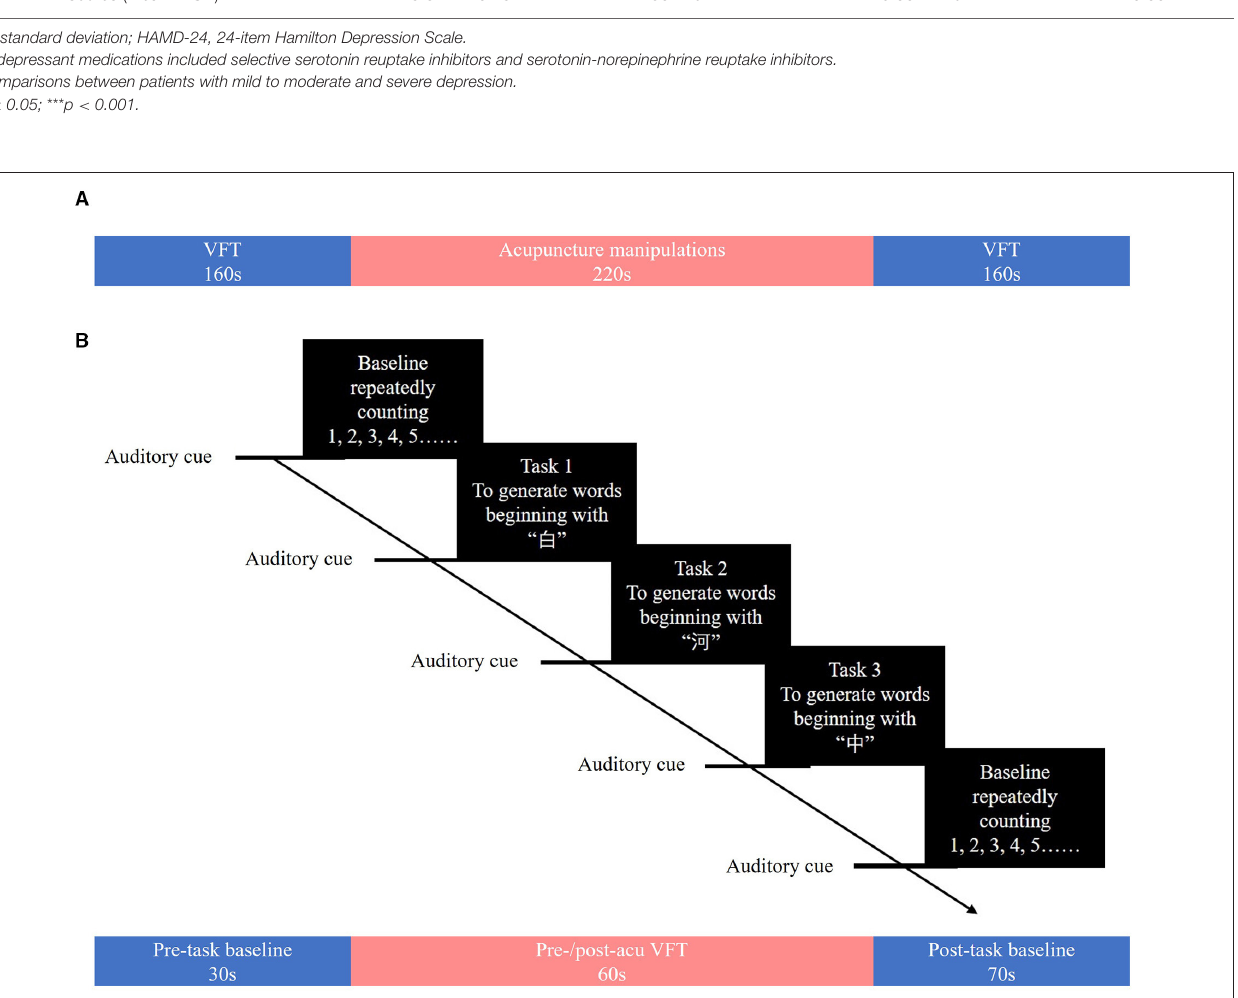
Frontiers in Psychiatry |